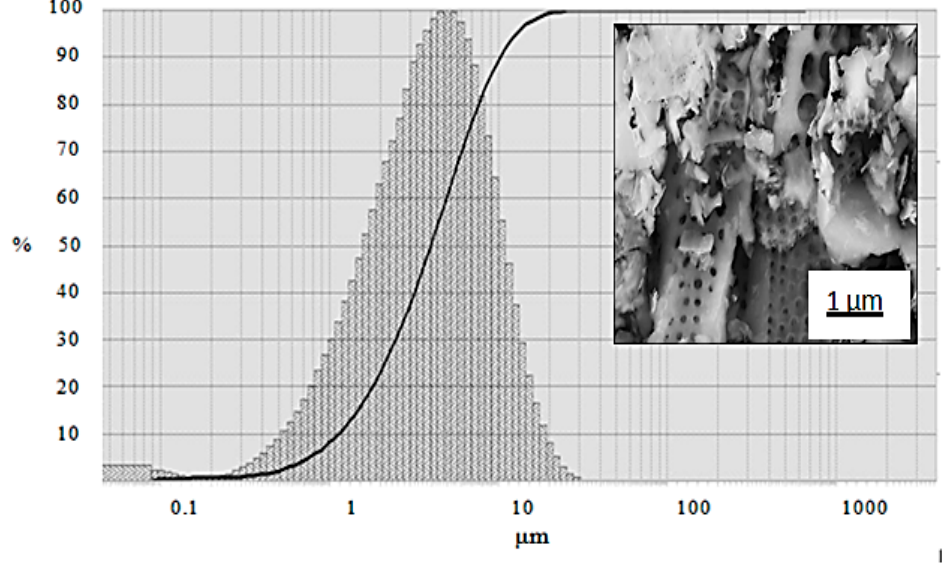
Figure 2. Powder particle size distribution of diatomite powder. Inset: SEM microstructural image of precursor diatomite powder showing crushed frustules with some porous structure.